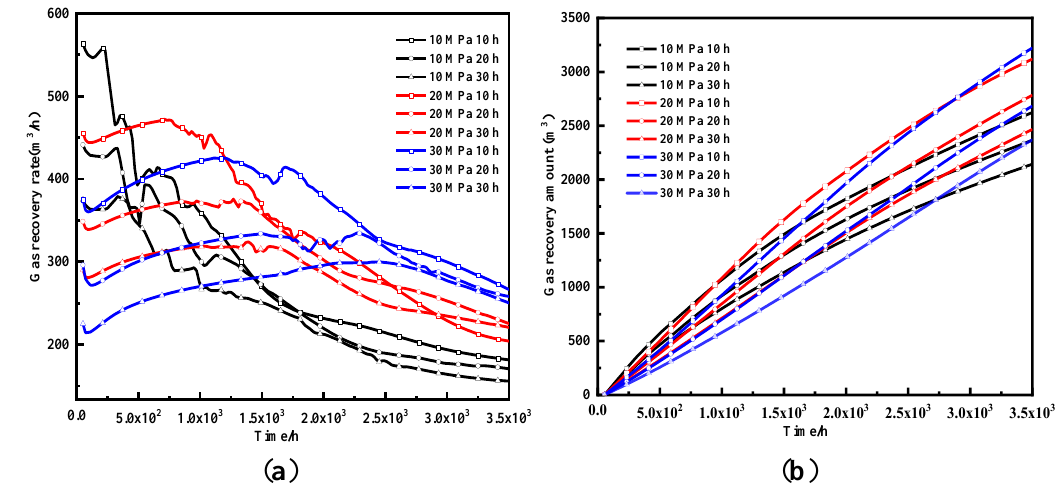
Figure 14. (a) gas production rate and (b) gas production amount with time.